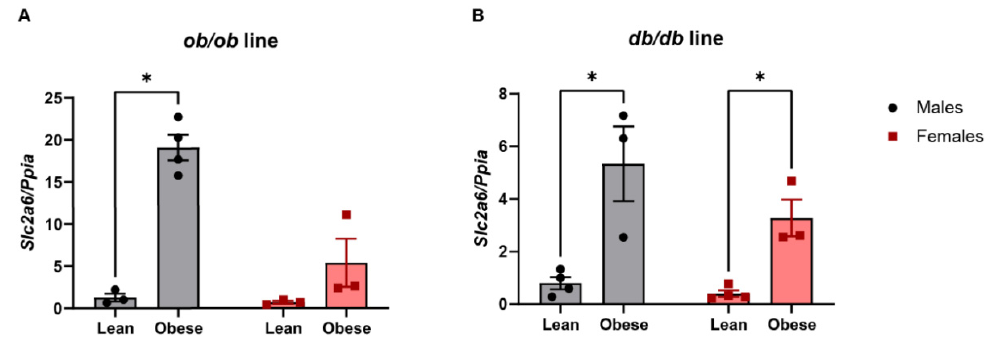
Figure 2. Slc2a6 mRNA expression was increased in islets obtained from obese ob/ob and db/db mice, compared to lean control mice. Slc2a6 expression data from isolated mouse islets of ob/ob ( A ) and db/db ( B ) mice, including males (black circles) and females (red squares). * indicates p < 0.05 by two-way ANOVA. n = 3–4 mice per group.